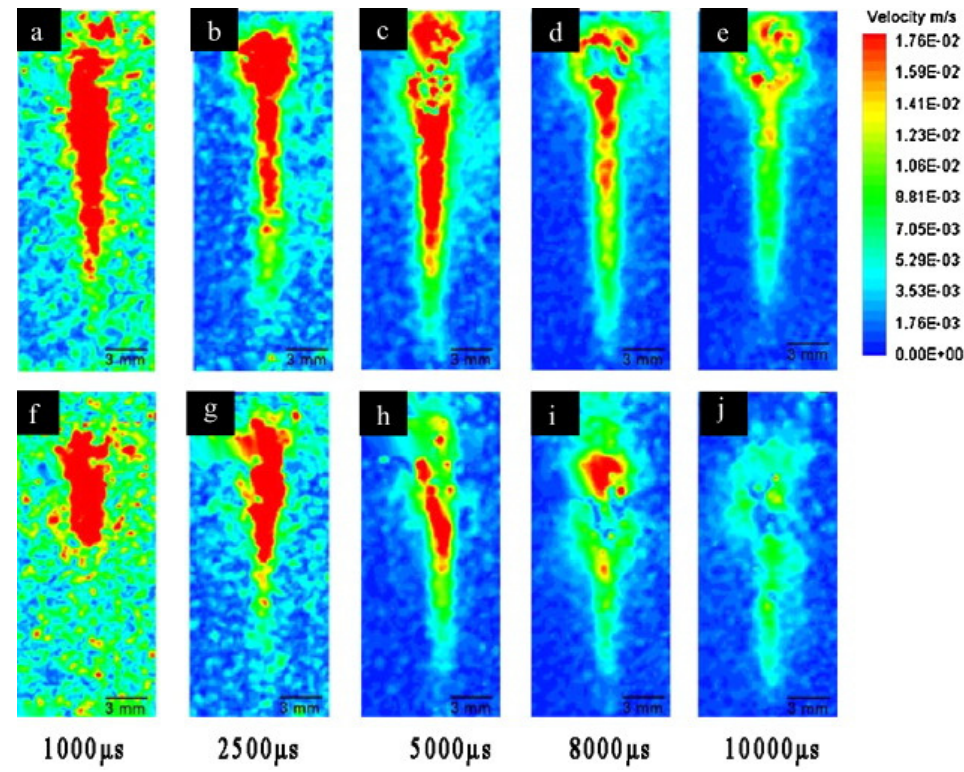
Figure 6. The interaction between an oil droplet and mineral particles as a function of time. ( a – e ) Modified kaolin (relative hydrophobic) and Alaska North Slope oil. ( f – j ) Original kaolin (hydrophilic) and Alaska North Slope [65] (Copyright 2011 Elsevier Ltd.).